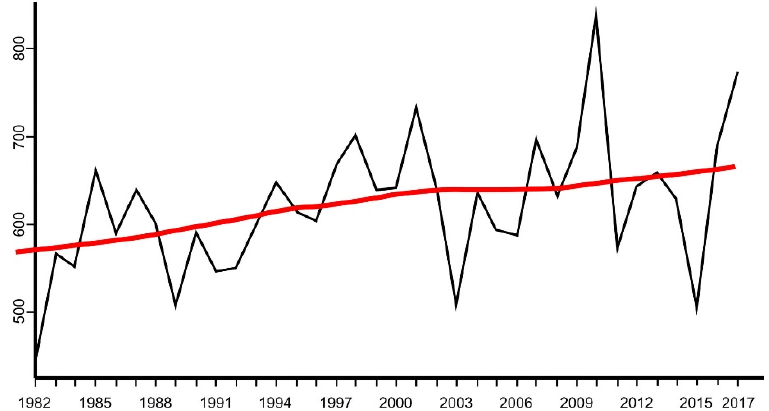
Figure 4. Annual total rainfall in Poland in the horizon from 1981 to 2017 (own elaboration from